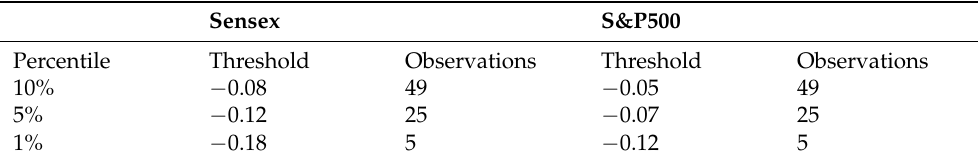
Table 3. Number of observations within the bottom percentiles of return